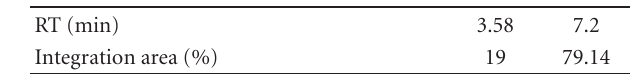
Table 1: RT and integration area of HPLC peaks about products after 15 mins of photoreaction in presence of Fe 3 O 4 @Au.